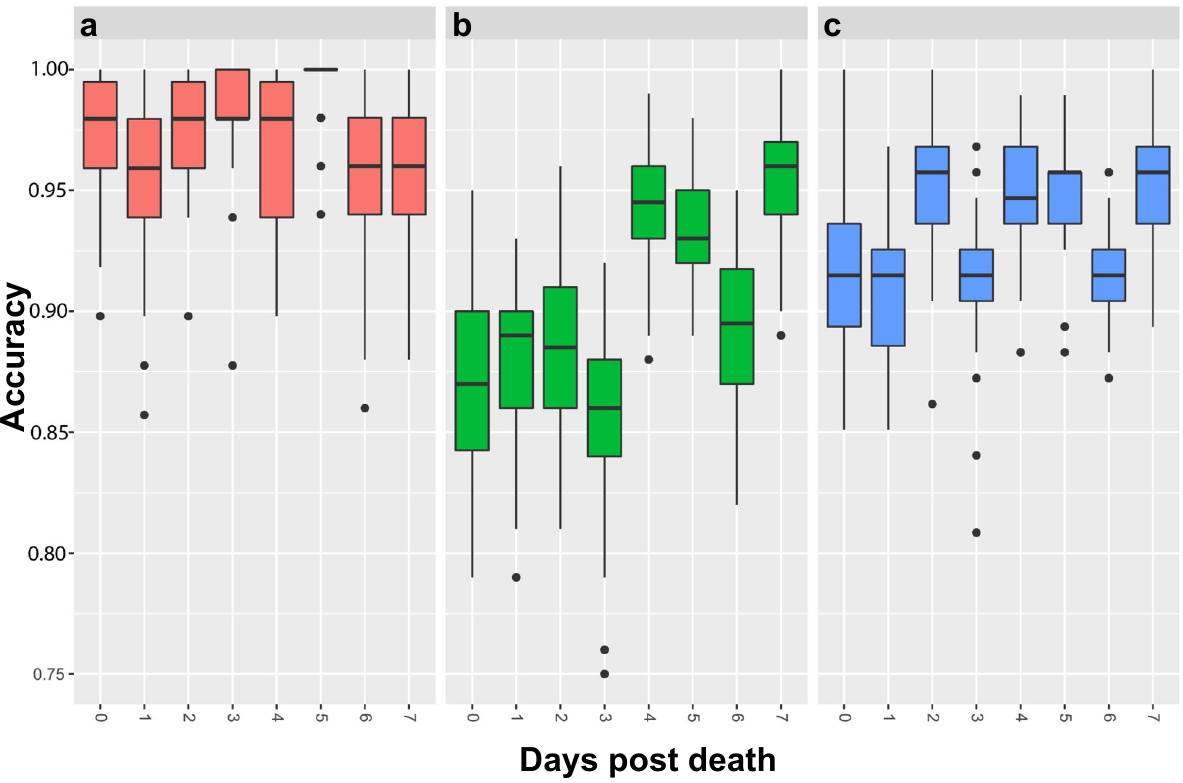
Fig. 3 Prediction accuracy (test set) for detecting infection in A. aegypti mosquitoes. Mosquitoes infected with CHIKV ( a ), Wolbachia ( b ), and ZIKV ( c ) vs. uninfected mosquitoes. Box and whisker plots follow the standard convention where the box represents the range between quartiles 1 and 3, while the whiskers represent maximum and minimum excluding outliers. Outliers are de fi ned as either Q1 − 1.5*IQR or Q3 +